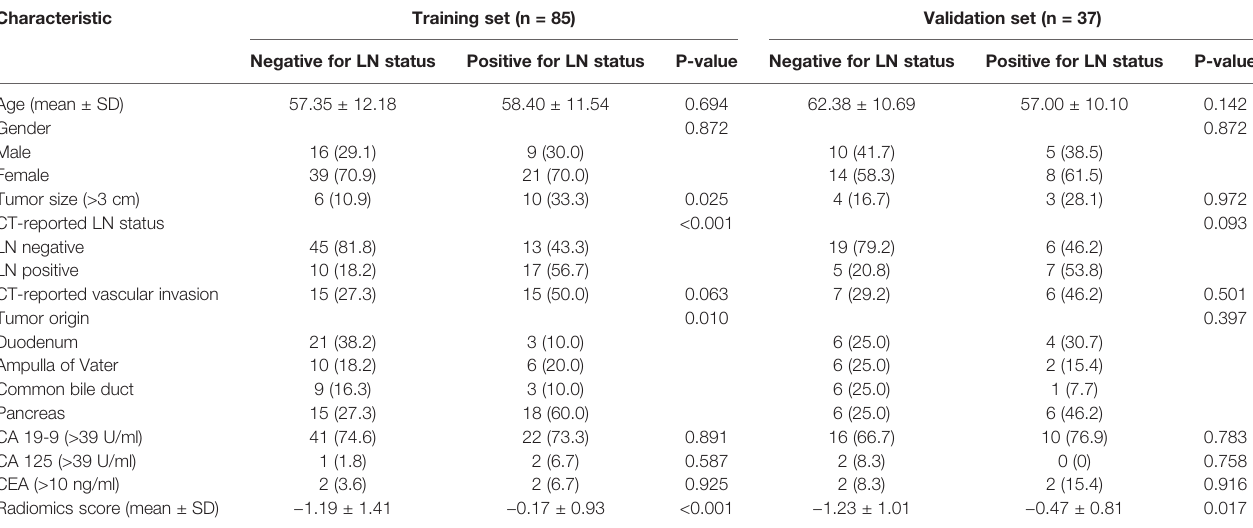
TABLE 1 | Characteristics of all patients in the training set and validation set.